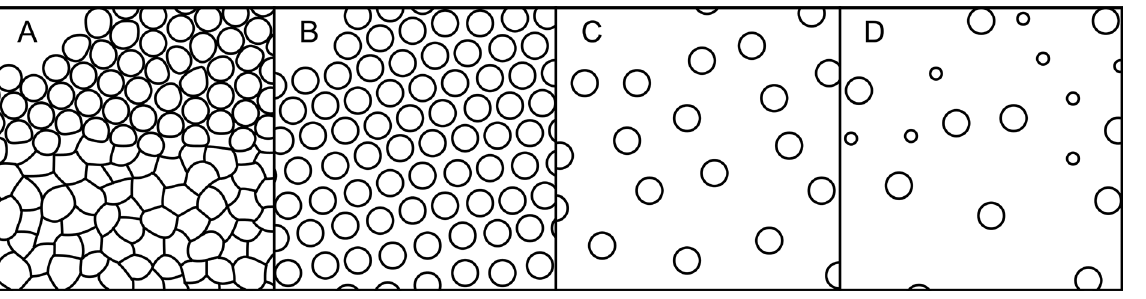
Fig. 2. Examples of punctation in Lasioglossum ( Dialictus ). A . Crowded (i = 0 pd) with few or no distinct interspaces in upper half to ruguloso-punctate in lower half. B . Dense (i < 1 pd) but distinct. C . Moderately dense in upper half to moderately sparse in lower half (i = 1–2 pd). D . Sparse (i = 1–3 pd) and diversopunctate in upper